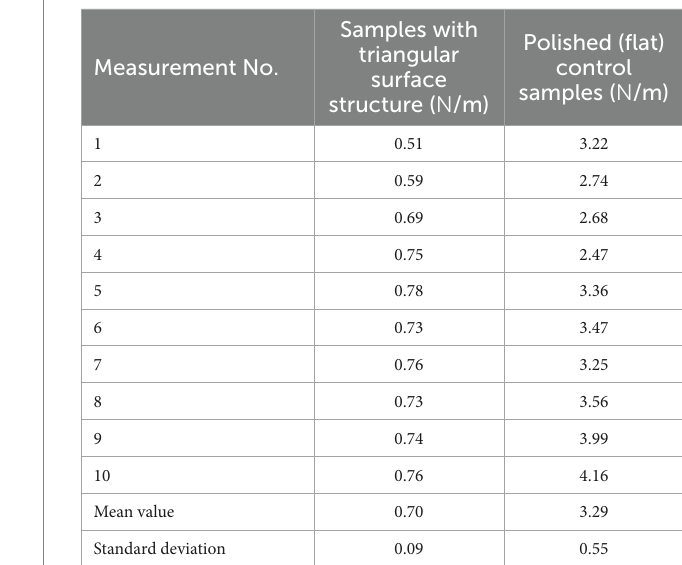
TABLE 1 Peel-off force per unit length measurement